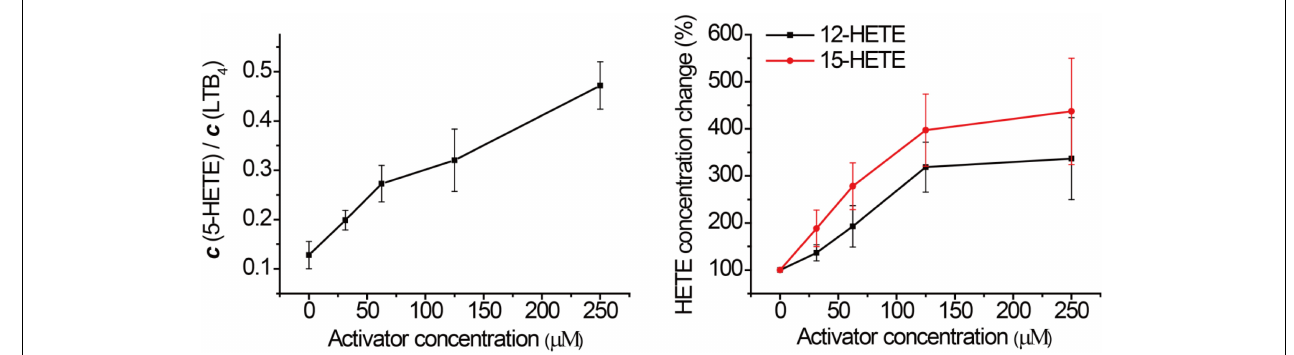
FIGURE 3 | Effects of compound 102 on LOXs activities in human PMN cells. Data shown represent the mean ± standard error of mean (SEM; n = 3).